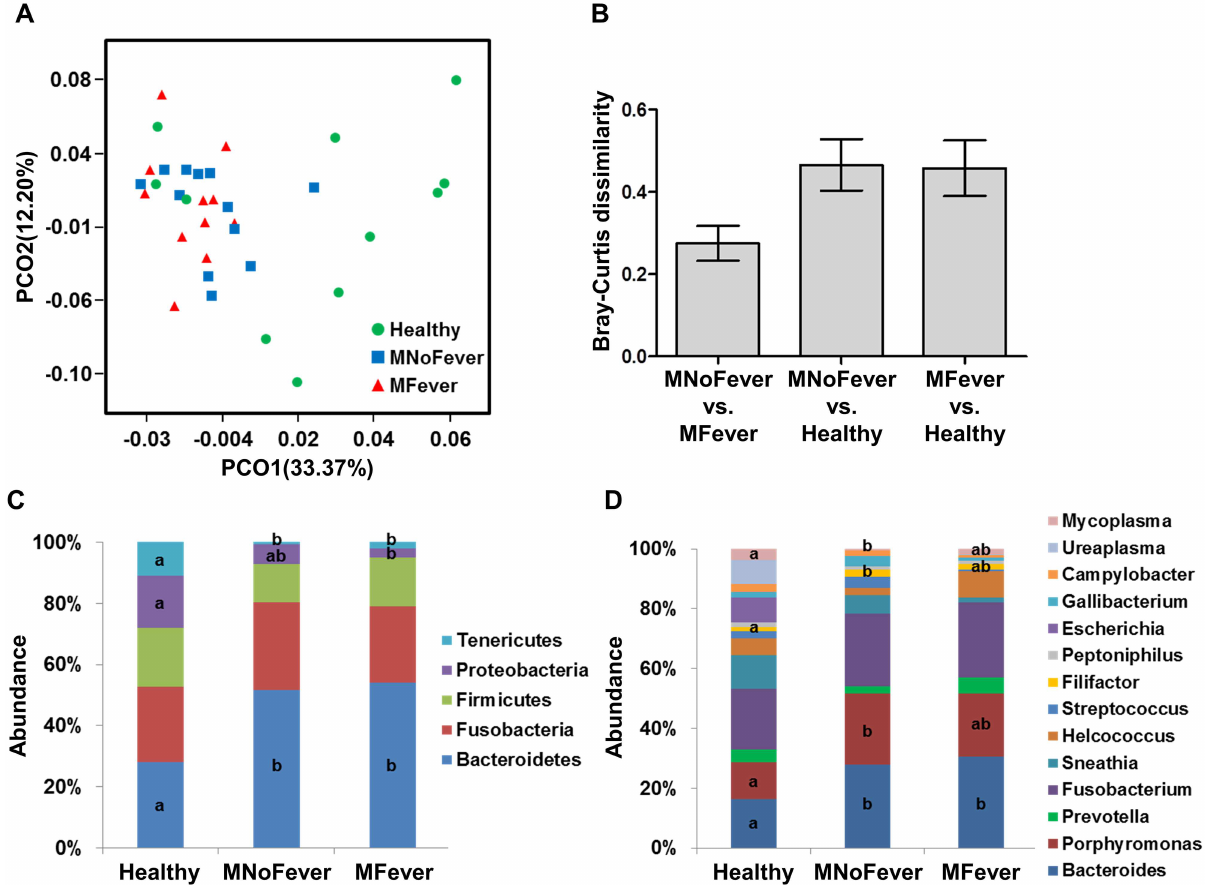
Fig 2. Dissimilarity of bacterial community. (A) Principal coordinates analysisof uterine microbiotabased on normalized values and Manhattan distance. This shows the ordinationof the Healthy (healthy cows; green circles), MNoFever (metritic cows without a fever; blue squares), and MFever (metritic cows with a fever; red triangles). Variance explainedby each PCO axis is given in parentheses. (B) Bray- Curtis dissimilarity of uterine microbiota using phylum level abundance of bacteria. An index of 0 indicatesthe most similarity between bacterial communities, whereas an index of 1 indicates the most dissimilaritybetween bacterial communities. Bars represent the mean ± SEM. (C) Phylum level assignment. (D) Genus level assignment. Bacterial phyla and genera having (cid:21) 1% abundancewere presented in a stacked bar graph. Data labeled“a” are statistically different ( P (cid:20) 0.05) from data labeled“b”.